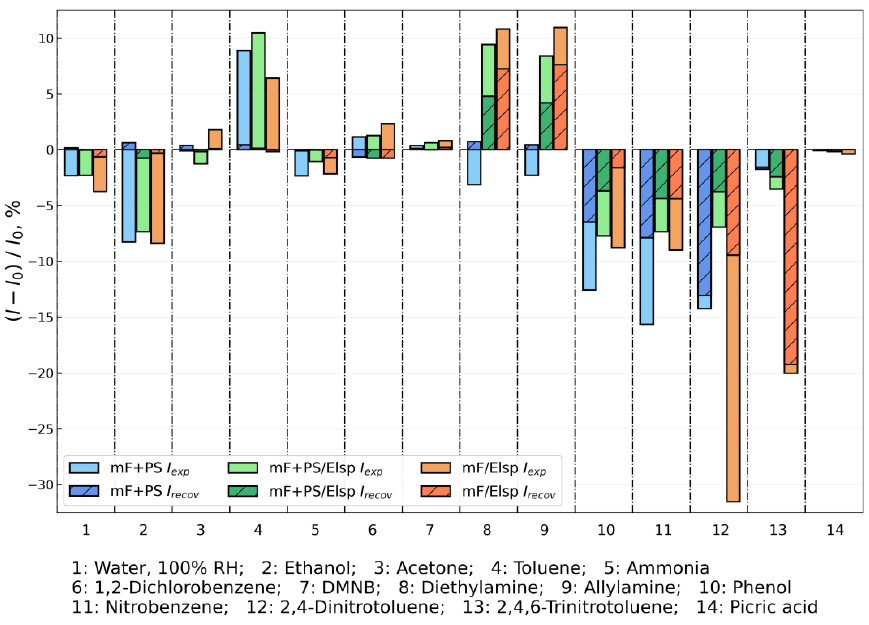
Figure 11. Fluorescence responses of obtained sensor materials towards saturated vapor of nitroar- omatic compounds and interferents (average response of three materials displayed).